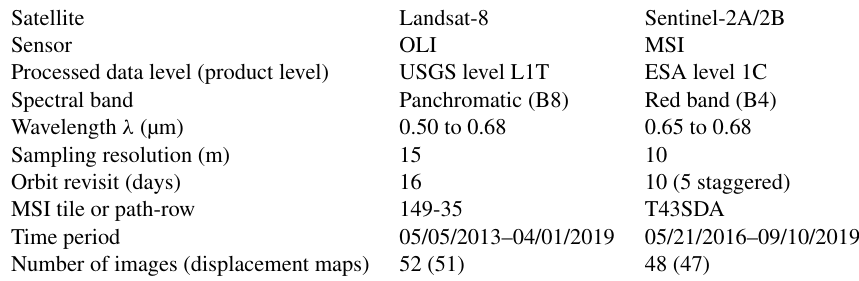
Table 1. Overview of satellite data products analyzed in this